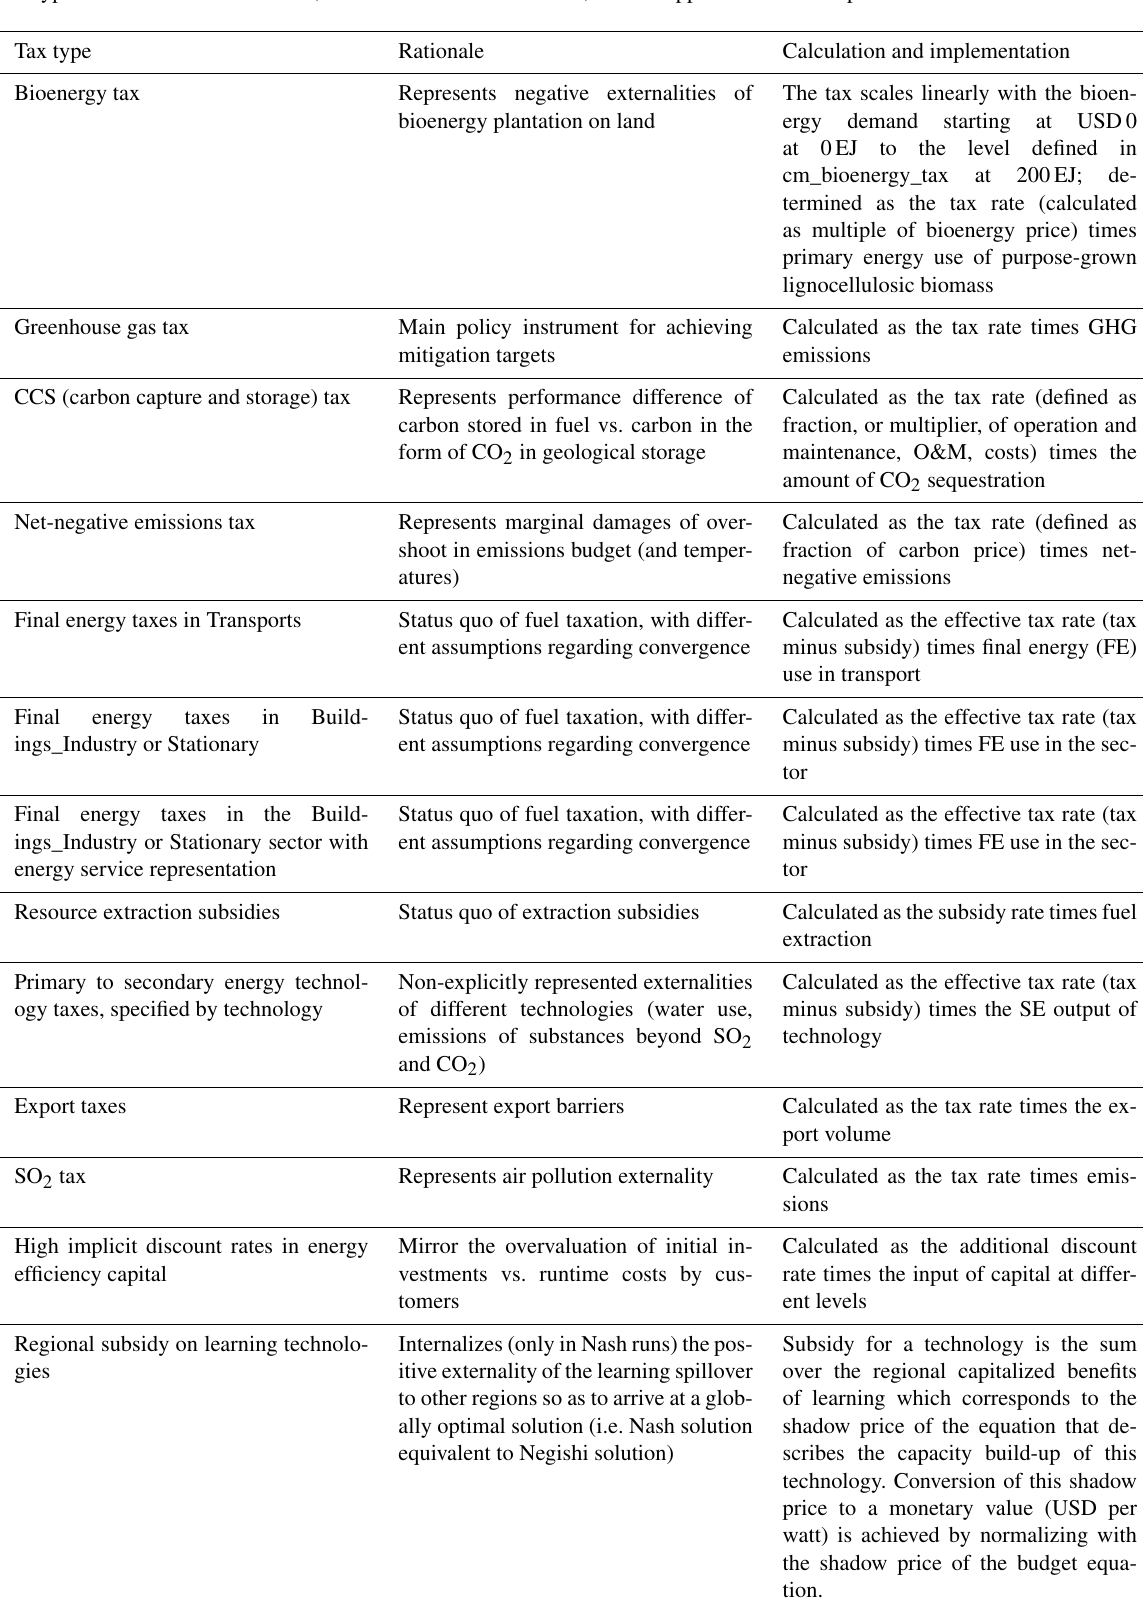
Table 1. Types of taxes within REMIND, the reason for their inclusion, and the approach to their